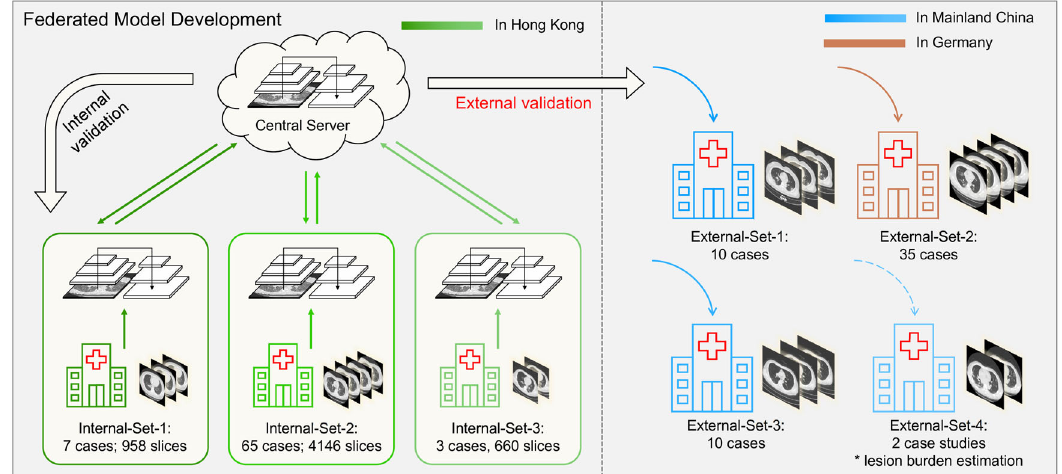
Fig. 1 Overview of our AI scheme to develop a privacy-preserving CNN-based model for detecting CT abnormalities in COVID-19 patients with a multinational validation study. A privacy-preserving AI system was developed with CT data from three hospitals in Hong Kong using federated learning, and then the generalizability was validated on external cohorts from Mainland China and Germany.